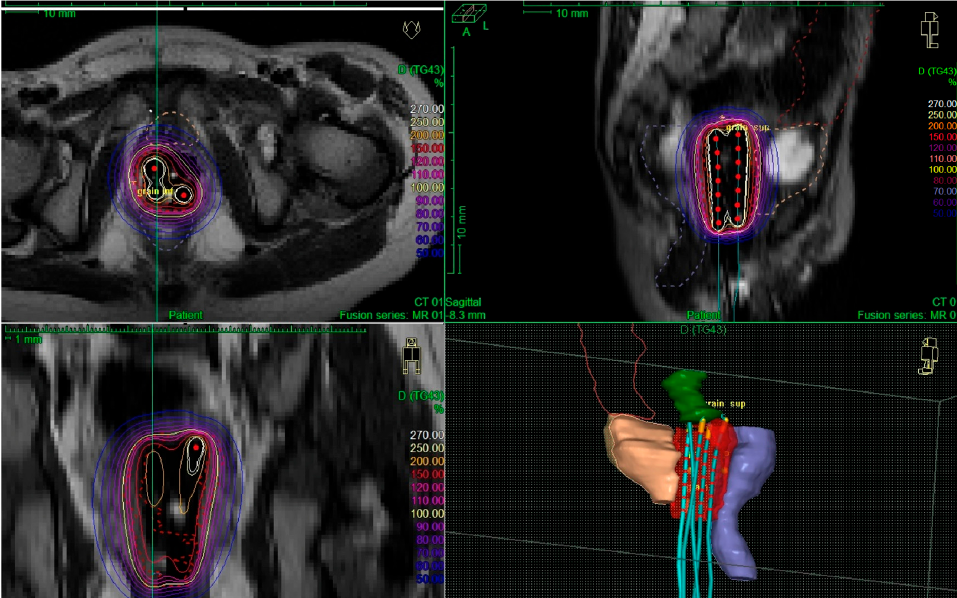
Figure 1. Example of an image-guided treatment for a 2-year-old girl with vaginal rhabdomyosar- coma. At the time of brachytherapy, there was multifocal residual disease involving the left and posterior parts of the vagina. An intracavitary procedure was performed with a vaginal mold ap- plicator (four catheters). The CTV is red, the bladder is orange, and the rectum is blue. The 100% isodose (60 Gy isodose) is shown in